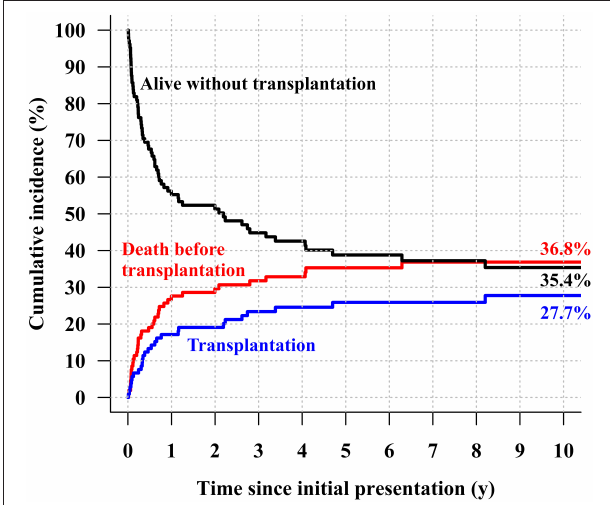
FIGURE 2 | Cumulative incidence of transplantation-free survival, death before heart transplantation, and heart transplantation.